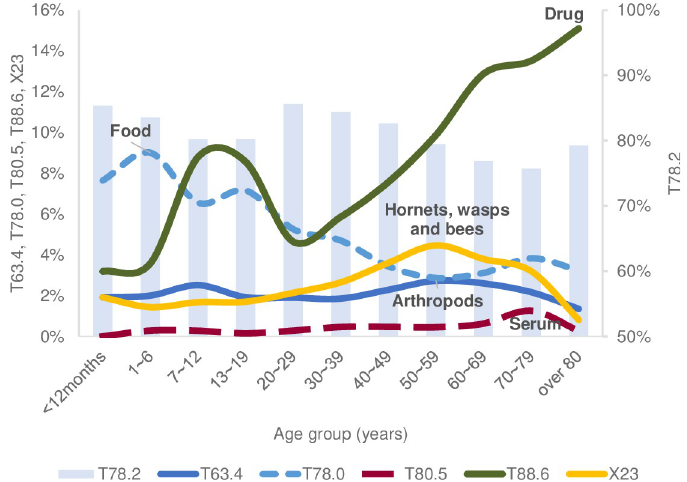
accounting for 69.4%. Among them, those in their 50s accounted for the most at 31.3% (Fig 7). Most cases of anaphylaxis caused by T88.6 (drug) occurred in 10 out of 16 administrative districts nationwide. However, X23 (hornets, wasps, and bees) was the most common in South Chungcheong, North Jeolla, and Gangwon. In North Gyeongsang, the most cases were due to T63.4 (arthropods), followed by X23 (Fig 8). The regions with the most X23 (hornets, wasps, and bees) were Gyeonggi (25.1%) and Gangwon (12.9%), and the district with the most T63.4 (arthropods) was North Gyeongsang (24.7%) and Gangwon (11.4%) (Fig 8).